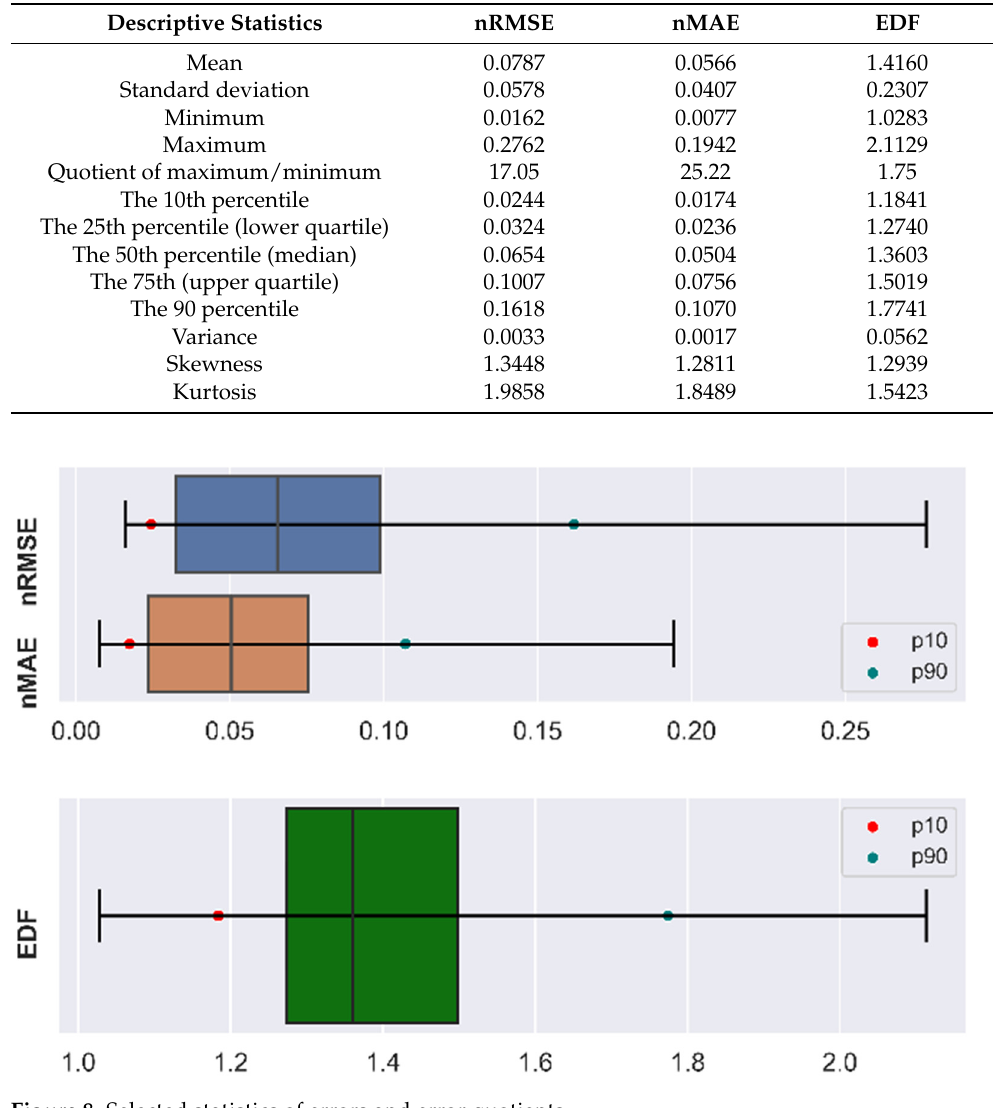
Figure 8. Selected statistics of errors and error quotients.